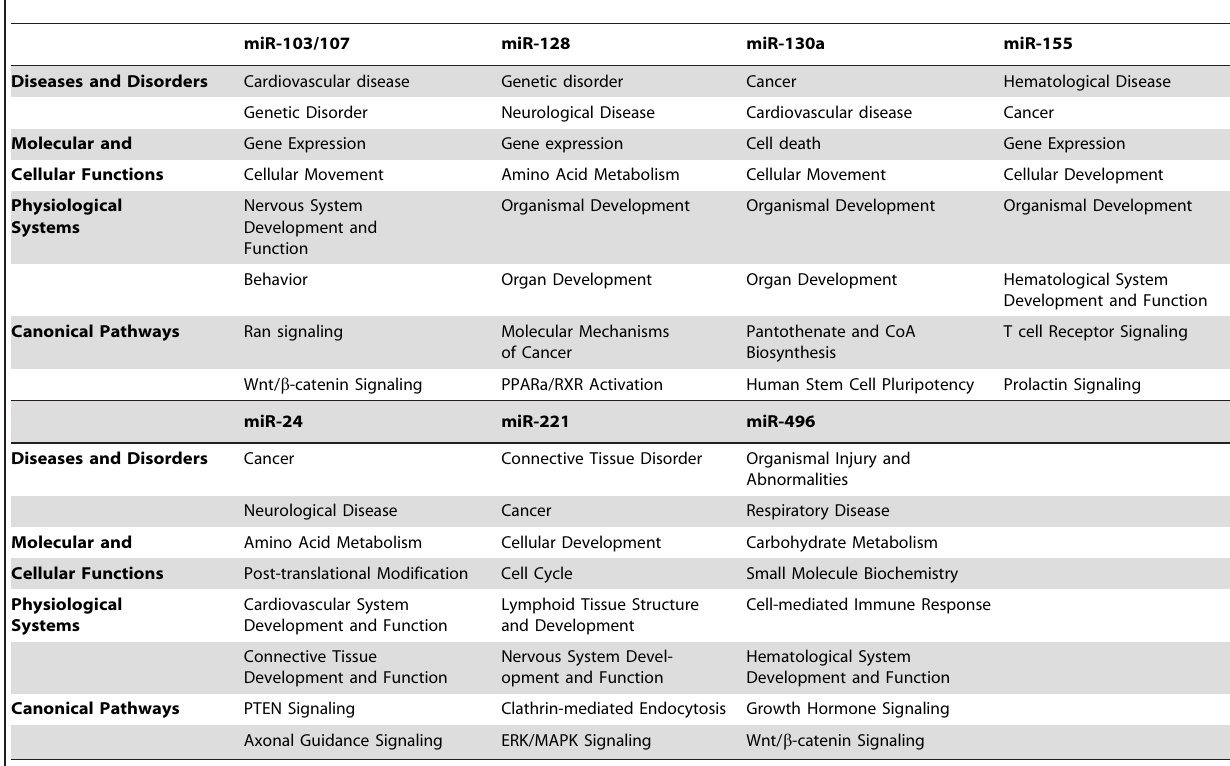
Table 2. Ingenuity analysis of microRNAs significantly downregulated with